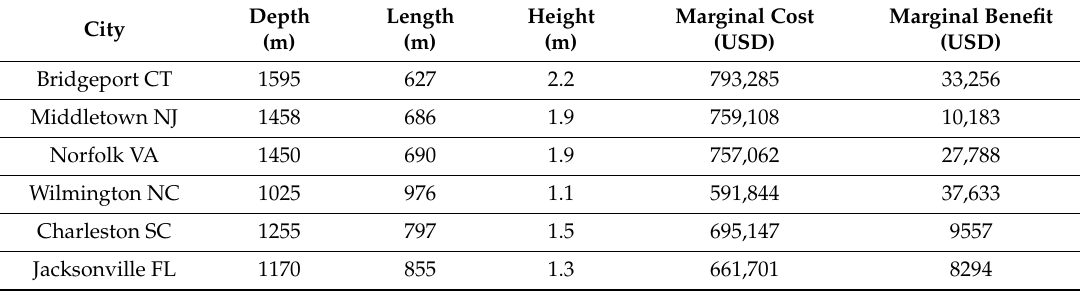
Table 2. Marginal cost versus expected marginal benefit to protect against 100-year storm. (Wall protects 1 km 2 area).